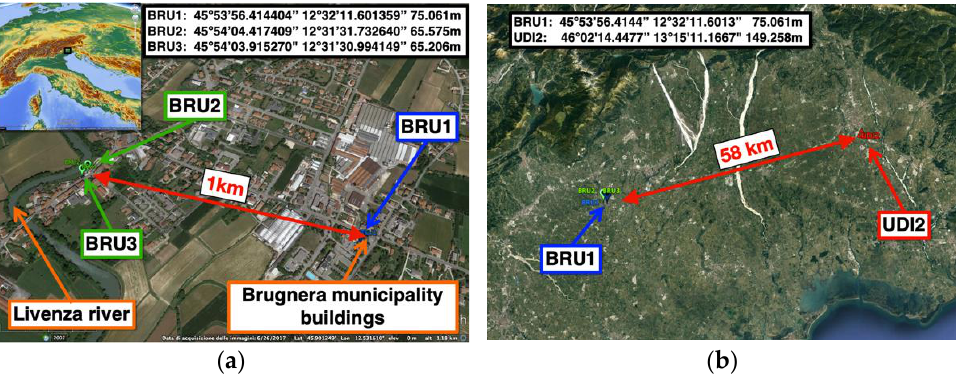
Figure 6. ( a ) Brugnera monitoring system configuration. BRU2 and BRU3 are the monitoring stations (Rovers) and BRU1 is the reference station (Master). ( b ) Performance test with BRU1 as a Rover and UDI2 as a Master station 58 km away.